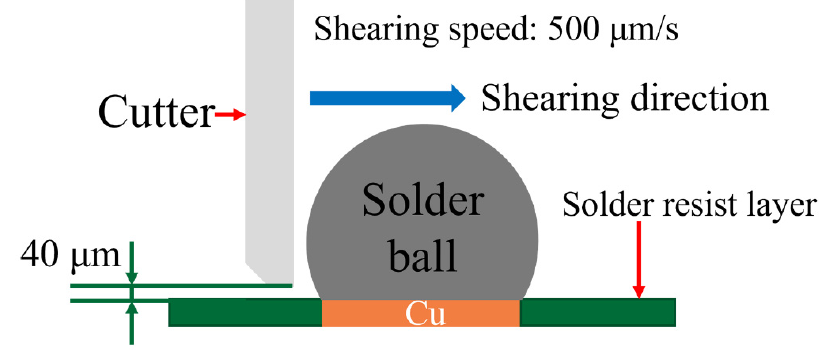
Figure 2. S chematic diagram of solder joint shear strength test. Figure 2. Schematic diagram of solder joint shear strength test.